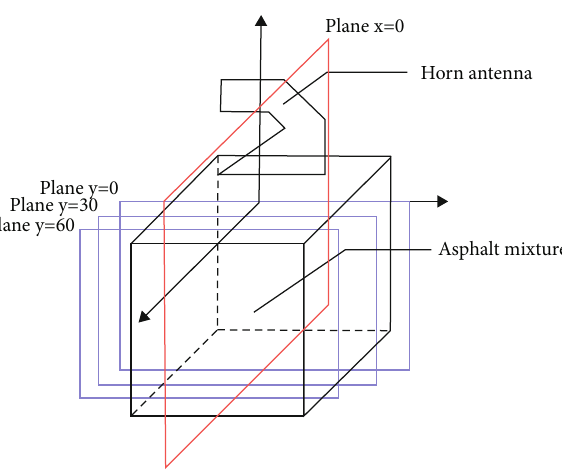
Figure 7: The location of the temperature measuring